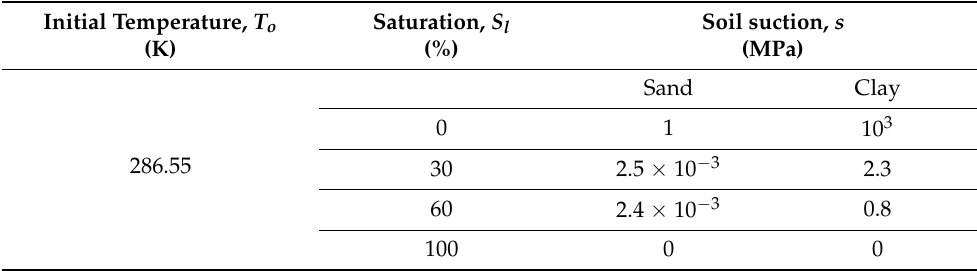
Table 2. Initial conditions for the sand and clay